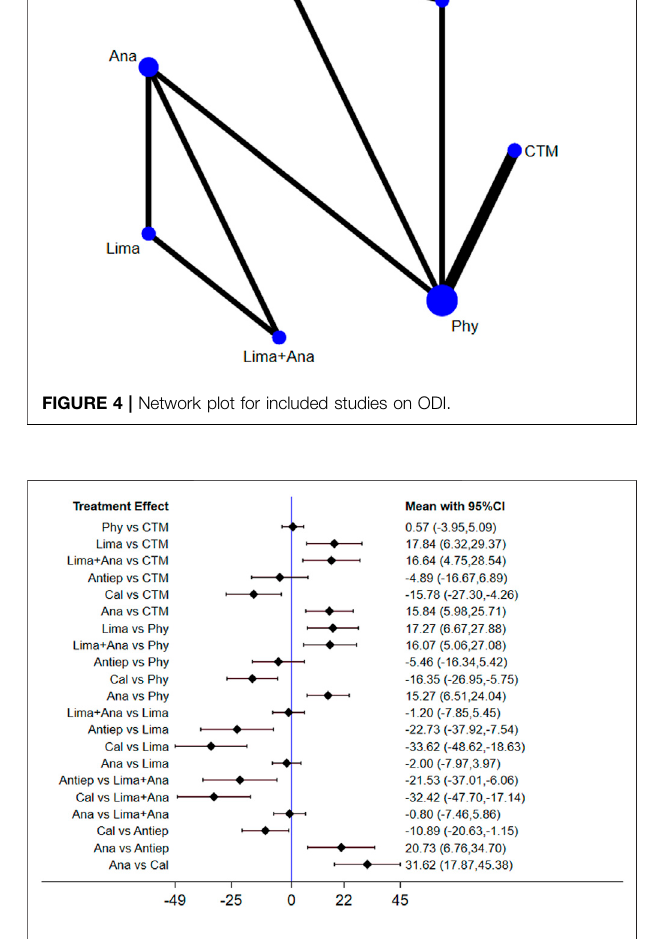
FIGURE 5 | Mean difference for ODI between treatments.